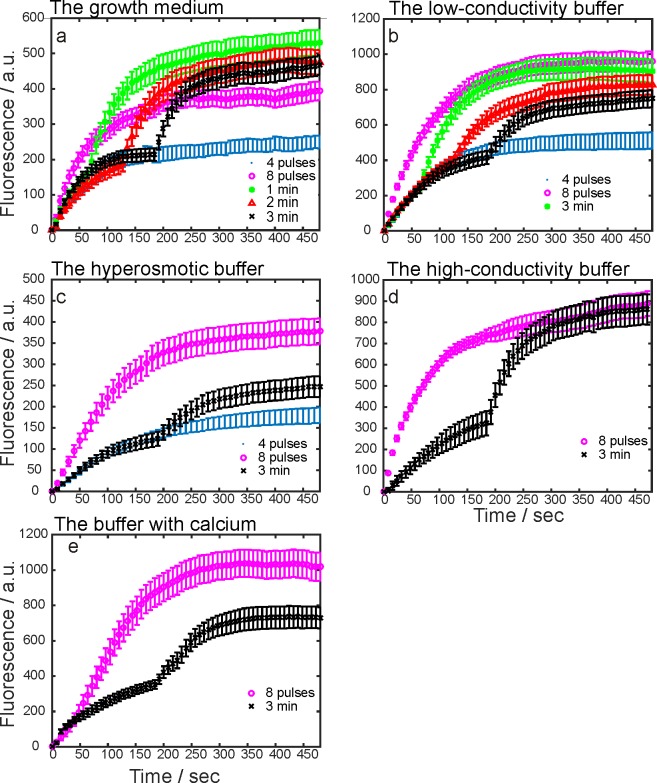
Measured fluorescence due to the propidium uptake in the growth medium and four different electroporation buffers.Propidium uptake was detected by fluorescence microscopy. On the y-axis, there are the average experimental values in arbitrary units ± standard error. On the x-axis, there is the time in seconds. (a), the growth medium; (b), the low-conductivity; (c) the hyperosmotic; (d), the high-conductivity buffer, (e) the buffer with calcium. The exposure times were different among the electroporation buffers.